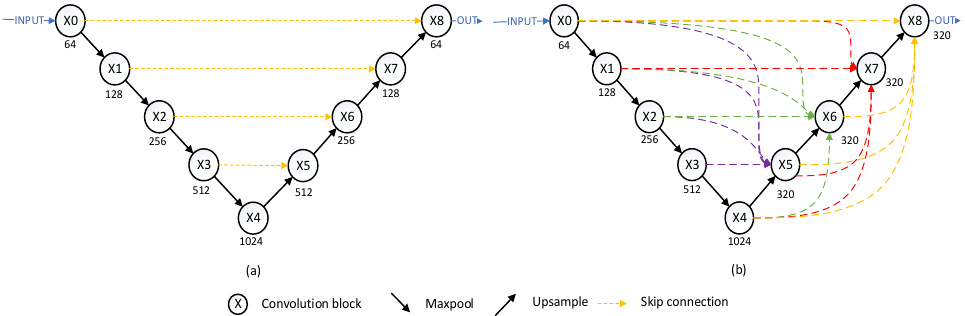
Figure 5. Comparison of skip connections: ( a ) UNet ordinary skip connections; ( b ) UNet3+ full-scale skip connections.